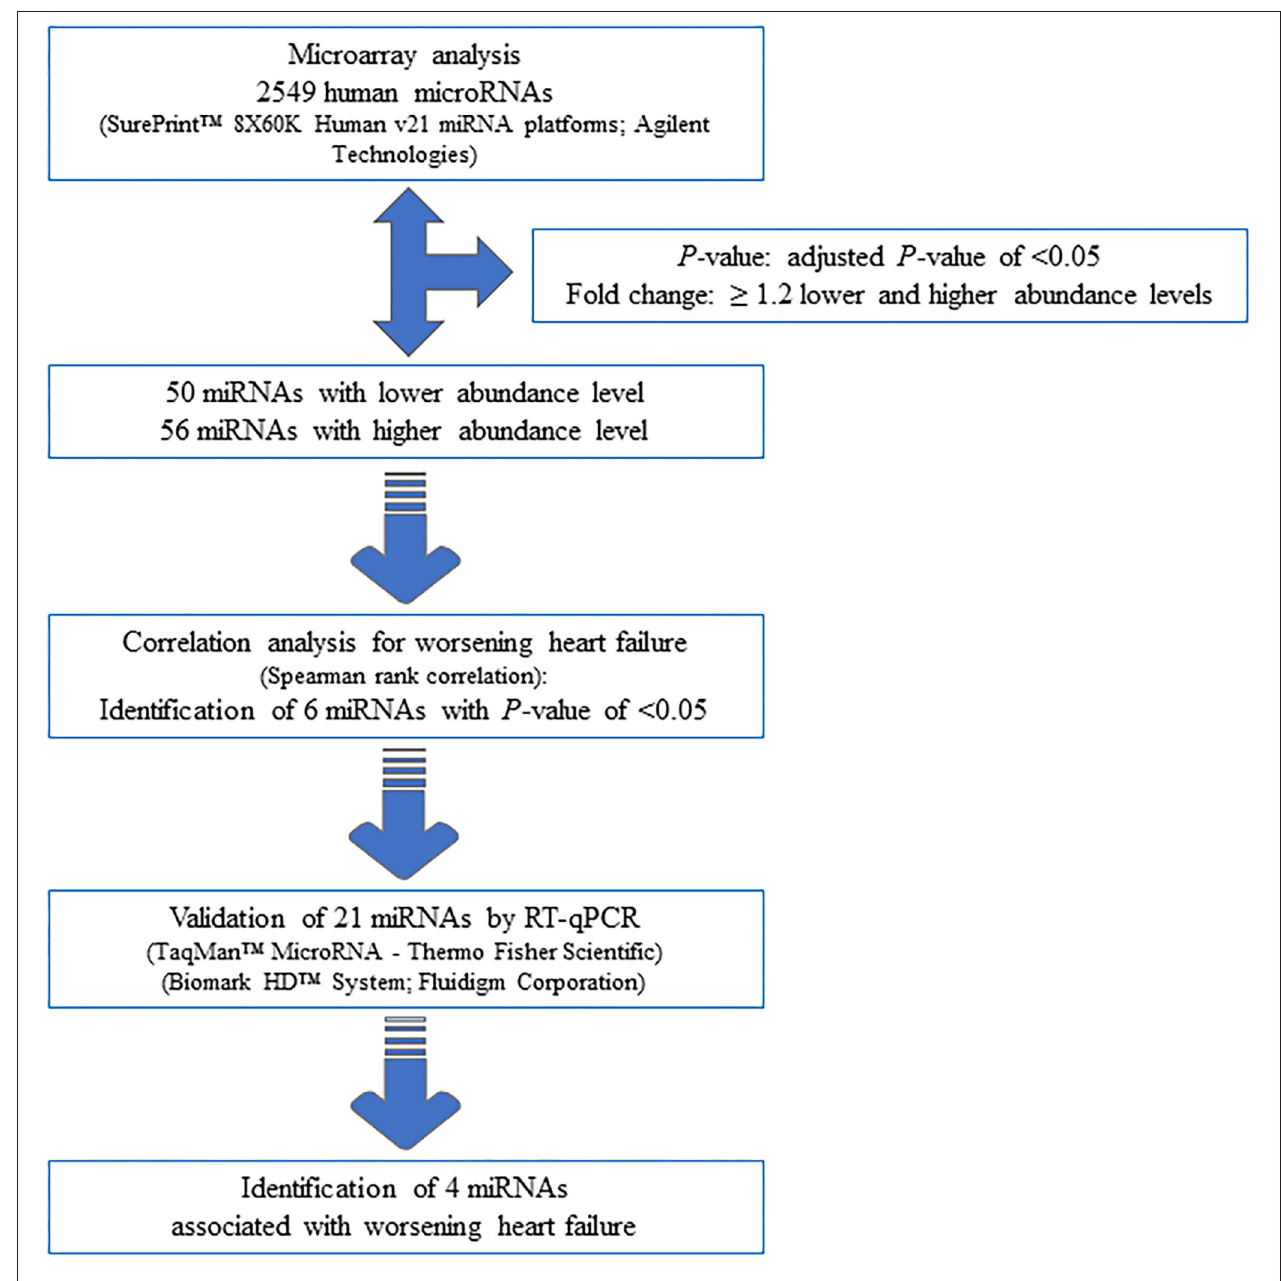
FIGURE 1 | Workflow of the analysis for the identification of miRNAs associated with worsening HF.